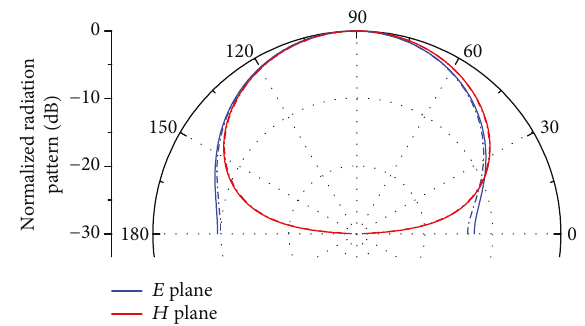
Figure 16: Normalized radiation pattern in the E and H planes of the HB antenna: solid line — Mathematica ; dotted line — HFSS.